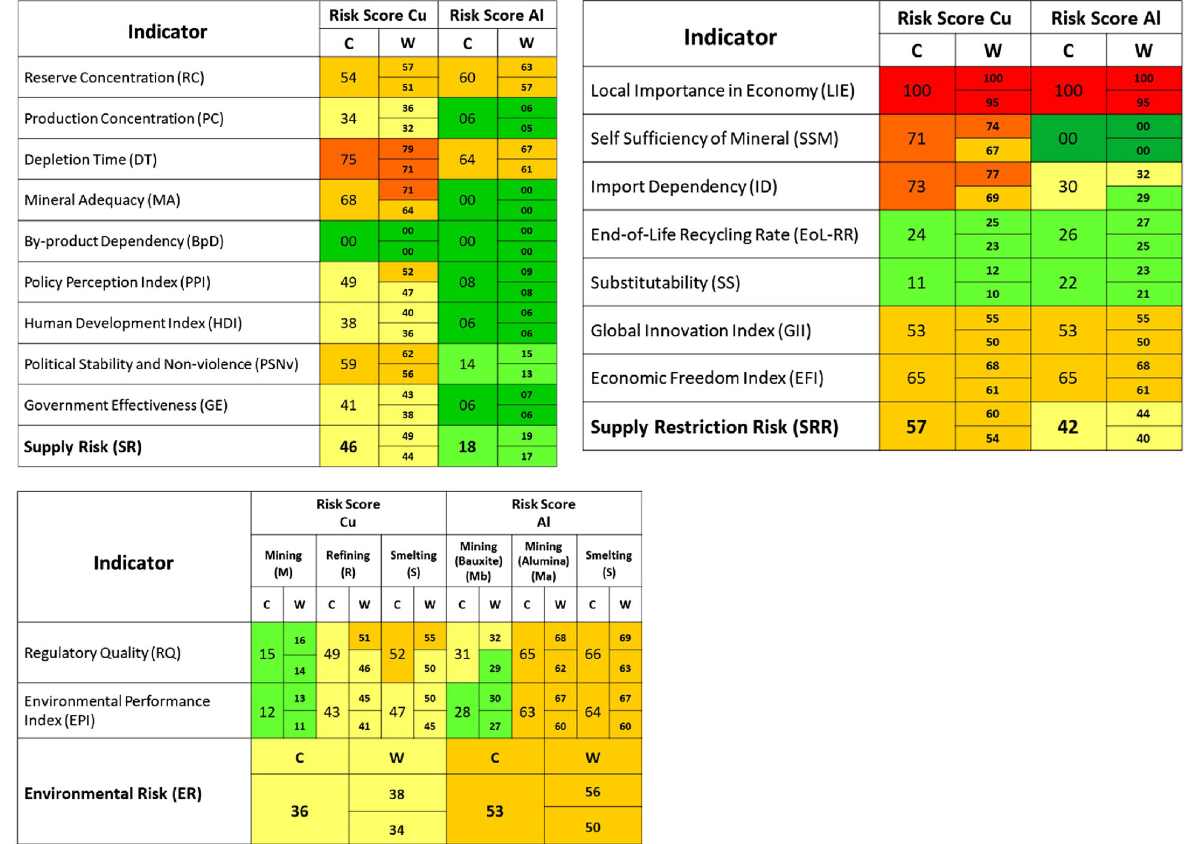
Fig. 3 The criticality evaluation for copper and aluminum in China. Results of each dimension (SR, ER, and SRR) are concisely interpreted. The step by step process to ascertain the risk score of each single indicator is vigorously explained with relevant data sources and assumptions in the Supplementary